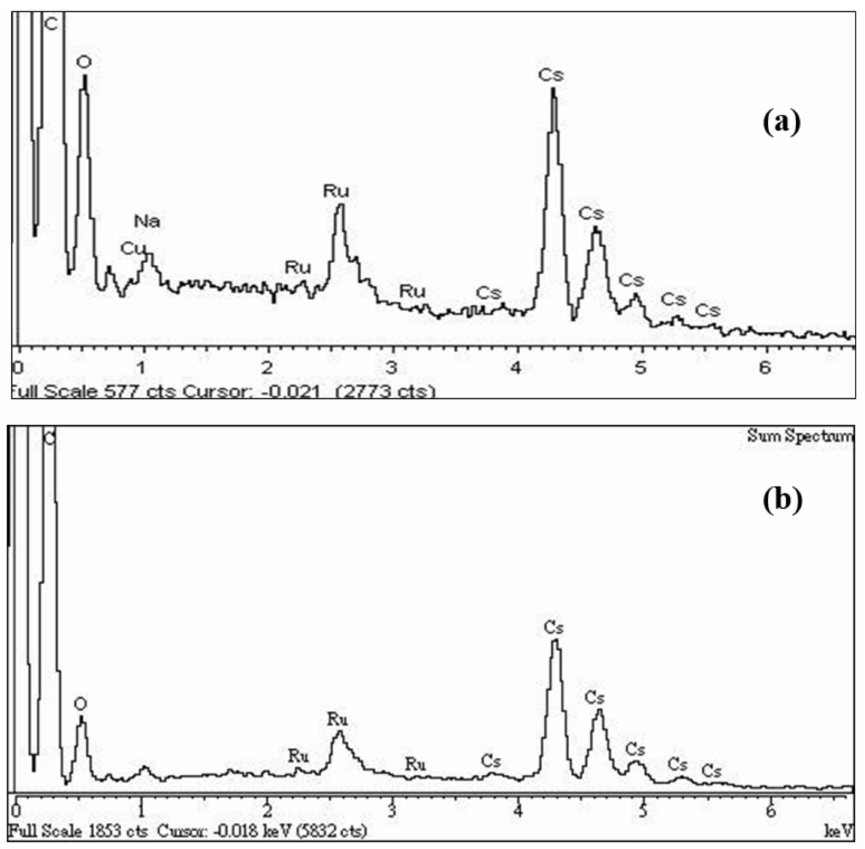
Figure 3. The EDS (energy-dispersive X-ray spectroscopy) spectrum of Ru-Cs/C particles for ( a ) Cs/Ru = 4 and ( b ) Cs/Ru = 6.